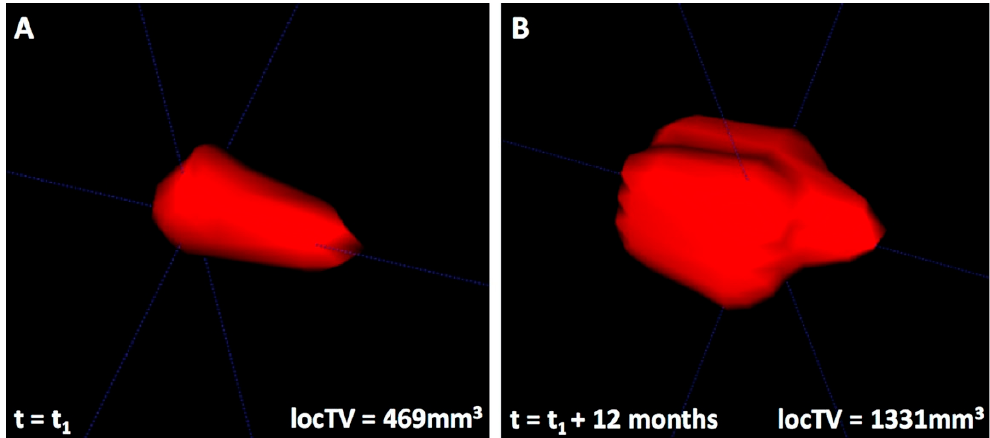
Figure 1. 3D spatial tumor development of a focal lesion over time (t) in a female patient (55 years at t = t 1 ). Segmented focal lesion images were acquired in a T2-weighted sequence and visualized by ITK-SNAP 3D-Viewer with relative scale and orientation. The presented focal lesion is located in the sacrum and shows a volume (V) of 469 mm 3 in ( A ) and of 1331 mm 3 12 months later in ( B ), corresponding to a speed of growth of 2.36 mm 3 /day.